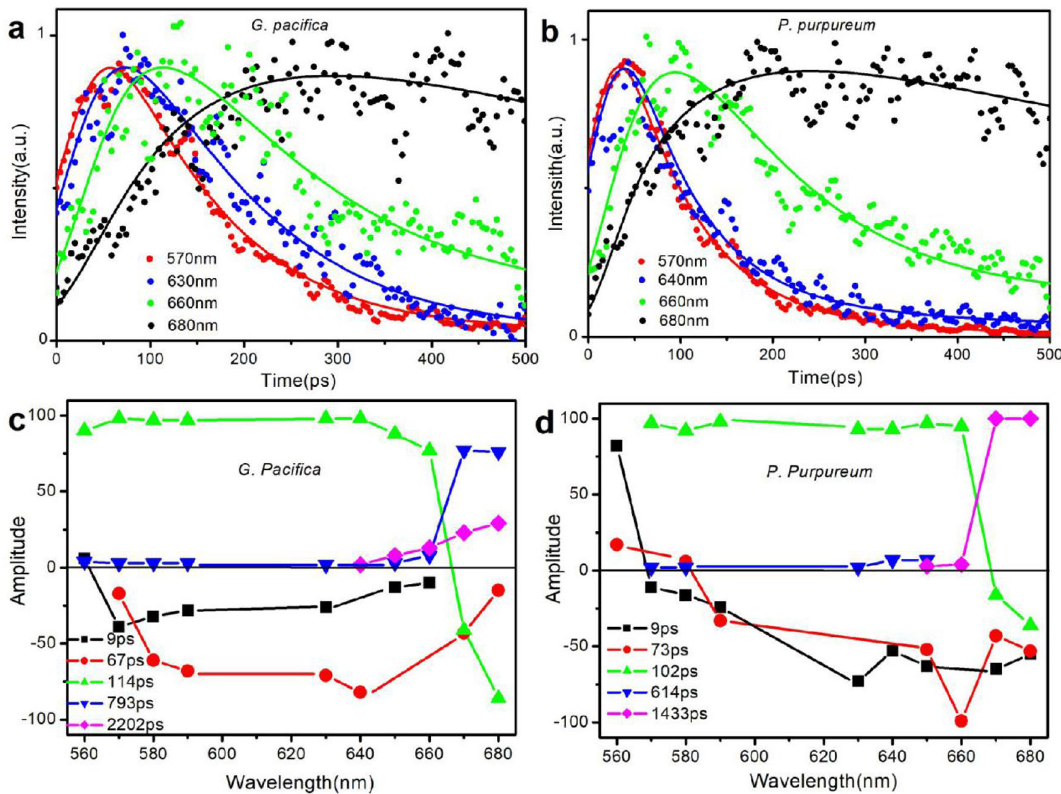
Figure 3. Fluorescence decay curves and DAS of two red algae PBSs. ( a ) Normalized fluorescence intensity decay curves of G. pacifica PBSs; ( b ) Normalized fluorescence intensity decay curves of P. purpureum PBSs . Excitation was done at 498 nm. Detection was done at 560 nm, 630 nm, 680 nm, respectively. Dots represent the experiment data, and the lines represent the fitting results; ( c ) DAS of G. pacifica PBSs; ( d ) DAS of P. purpureum PBSs